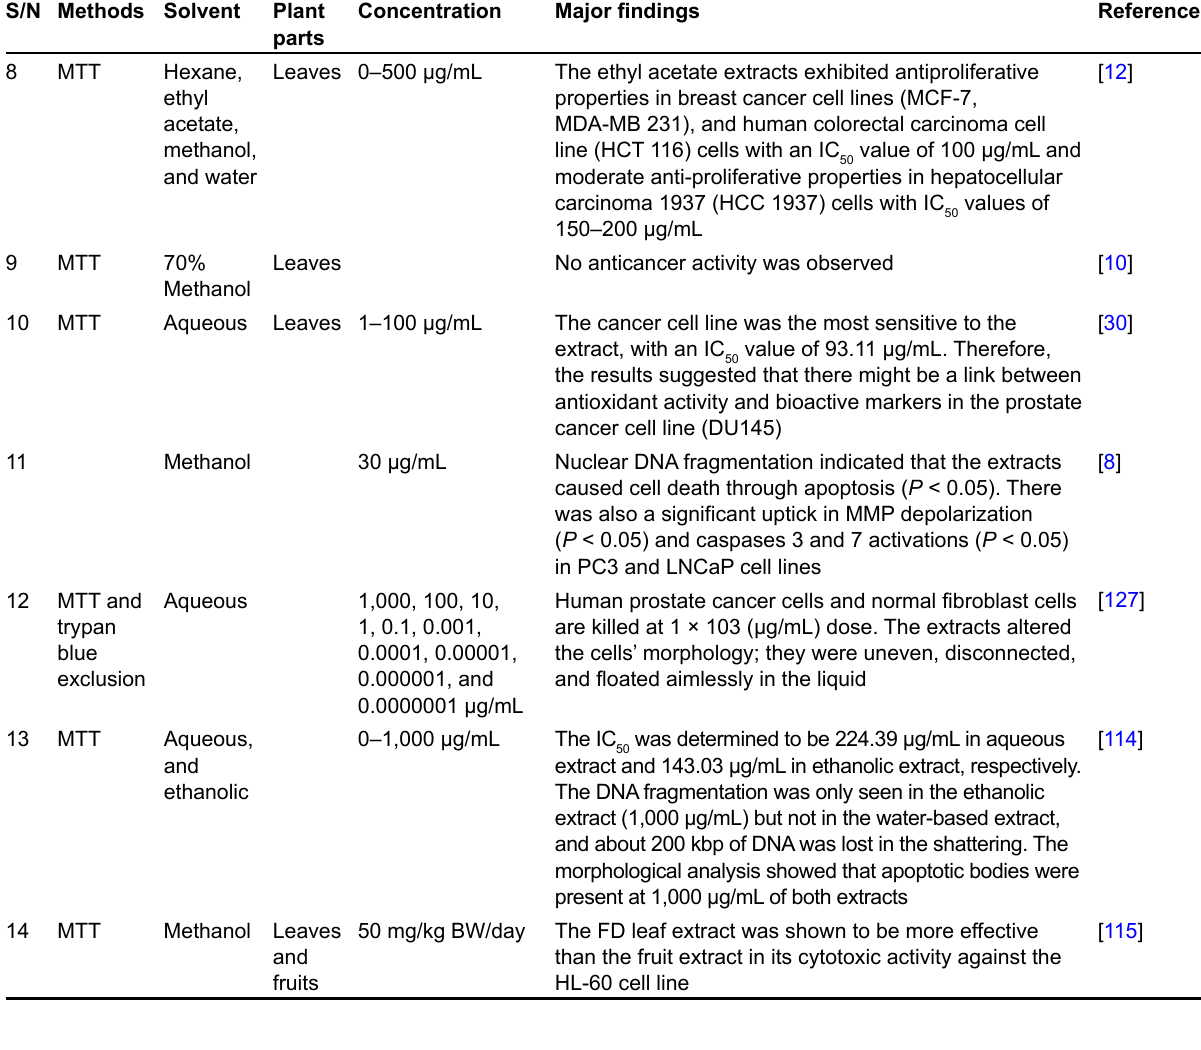
Table 8. Anticancer activity of FD ( continued )